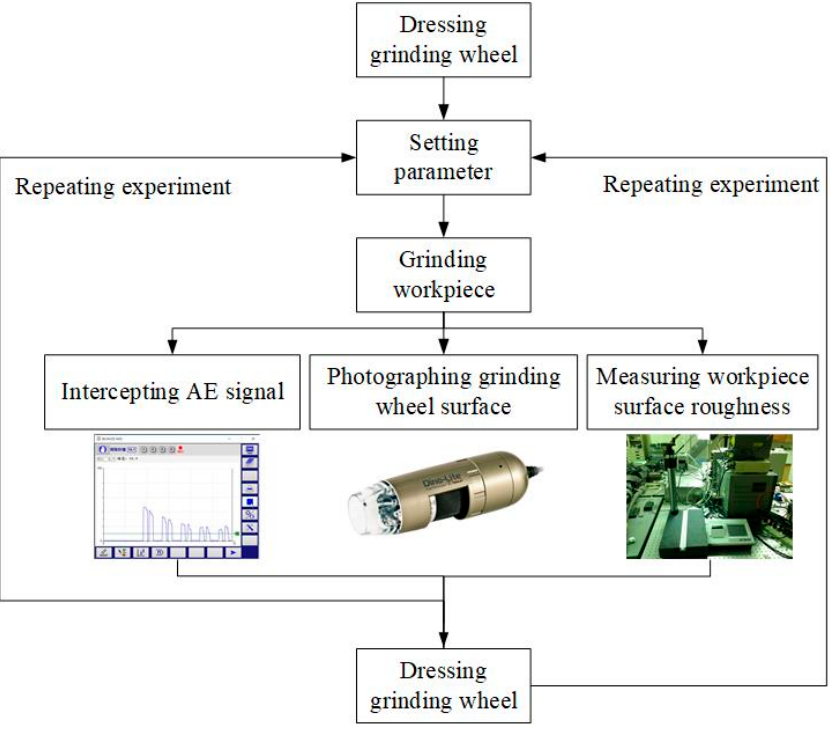
Figure 3. Flow chart of grinding procedure.